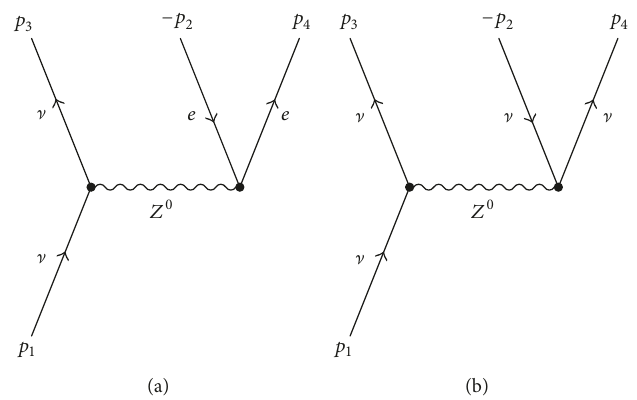
Figure 1: The decay process in (a) involves a faster-than-light neutrino decaying into an electron-positron pair, with a threshold 𝑞 2 = 4𝑚 2 𝑒 for the virtual 𝑍 0 boson. In (b), a neutrino-antineutrino pair is emitted from an oncoming energetic neutrino. Both processes are kinematically allowed if one assumes that neutrinos are tachyons described by a dispersion relation of the form 𝑝 𝜇 𝑝 𝜇 = 𝐸 2 −